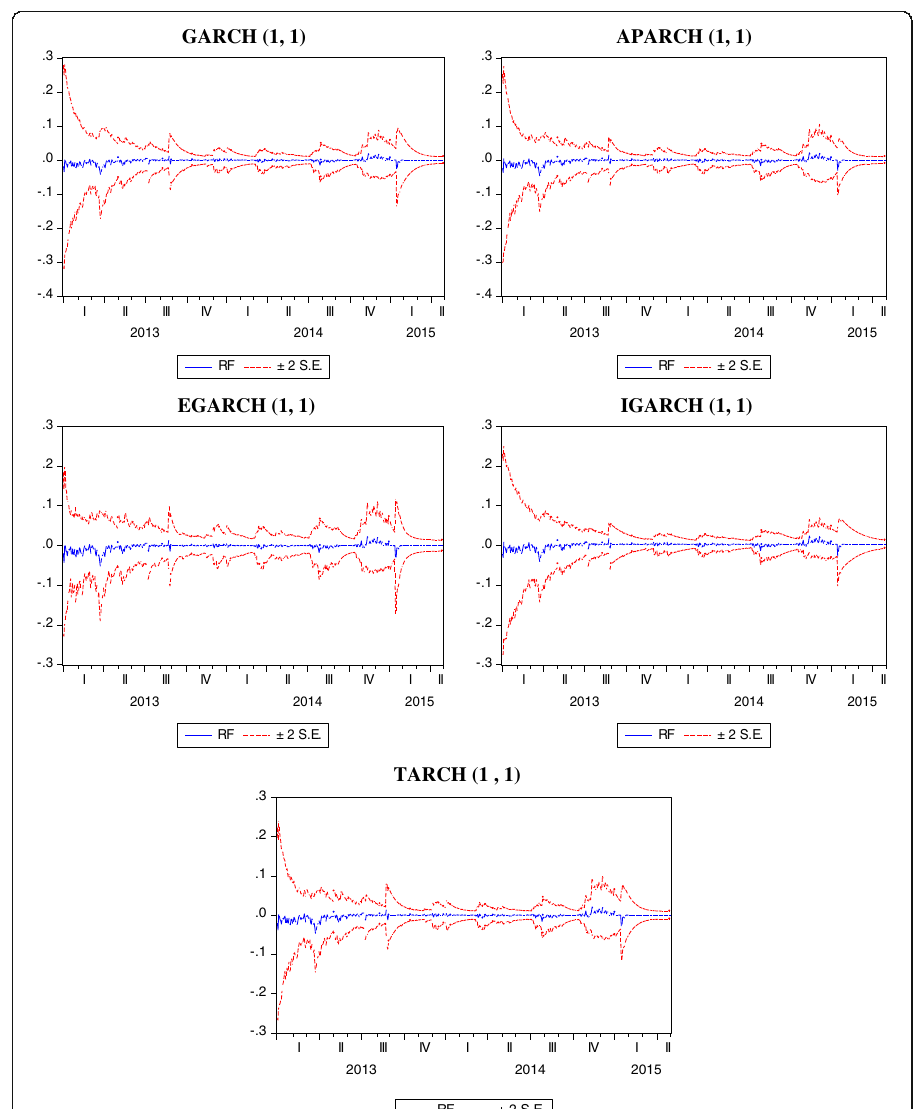
Fig. 4 Volatility forecasting with normal